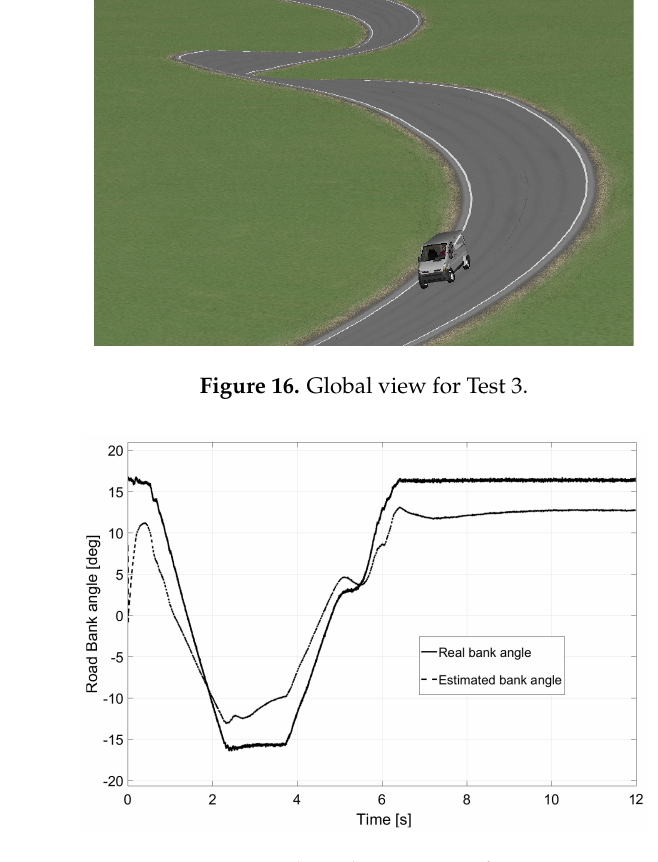
Figure 17. Bank angle estimation for Test